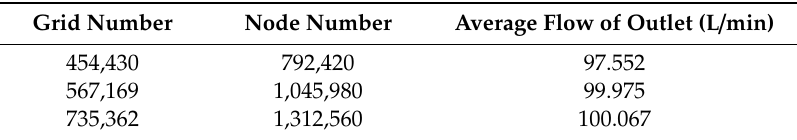
Table 4. Comparison of simulation results under different grid numbers.